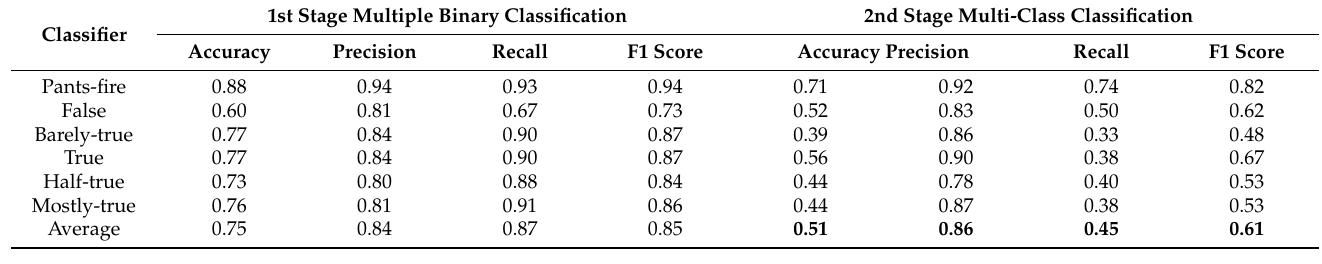
Table 3. Classification Performance for LIAR Dataset.